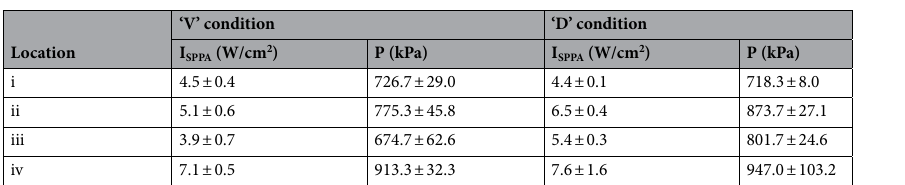
Table 1. Percent intensity transmission (with respect to the free-water maximum of 5 W/cm 2 I SPPA ), in situ I SPPA (in W/cm 2 ), and peak-to-peak pressure (P, in kPa), numerically estimated at four different locations—(i)– (iv) from Fig. 5. Average ± standard deviation ( n =